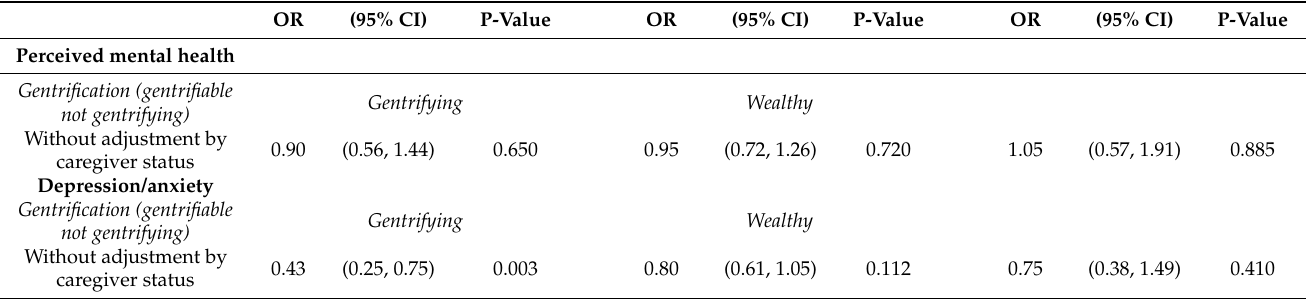
Table A3. Sensitivity analyses, testing main analyses for perceived mental health and depression/anxiety in the gentrifica- tion models without the “caregiver status”